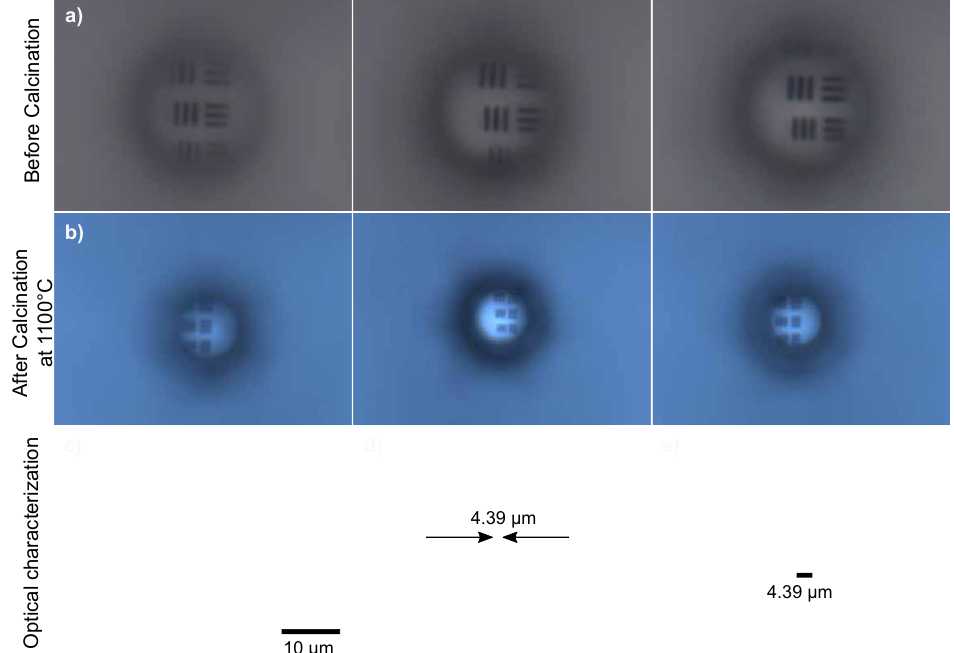
Figure 4. Optical performance of the produced micro-lenses. The top ( a ) row shows the imaging of a target prior to calcination while the middle row ( b ) shows the imaging after calcination. Bottom row: ( c ) Optical image of the calcinated structure. All lenses presented a resolving power of 4.39 µ m (228 lp/mm group 7 item 6 in the 1951 USAF target). ( d ) Image of the lines of the target and, ( e ) image of a “X1” characters performed by a calcinated transparent